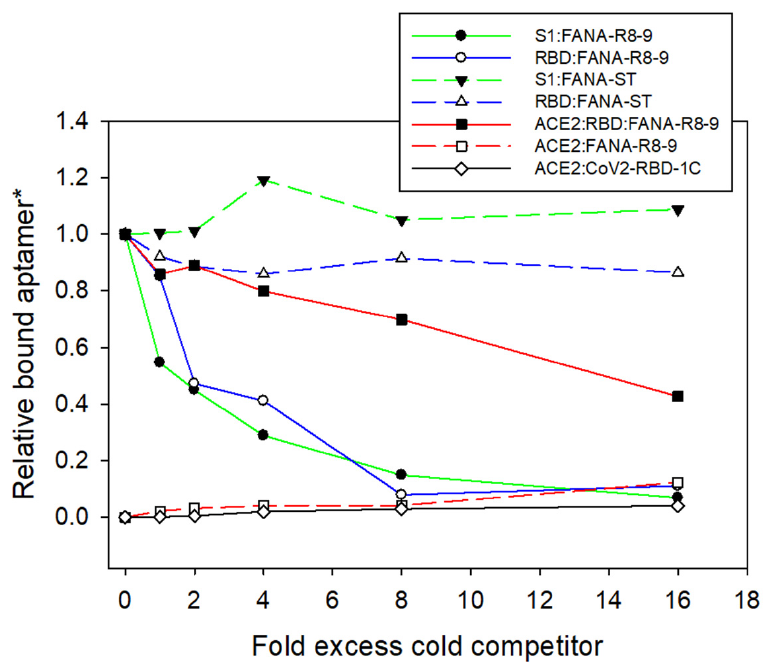
Figure 3. Competition binding assay with SARS-CoV-2 RBD and S1 proteins. Samples contained 10 nM of 5 (cid:48) - 32 P end-labeled FANA-R8–9 aptamer and 10 nM of either RBD or S1 proteins (see below). Cold competitor (FANA-R8–9, FANA-ST (starting material for SELEX), or ACE2 protein) was added at 0, 1, 2, 4, 8, and 16-fold excess over labeled FANA-R8–9. RBD and S1 were omitted from